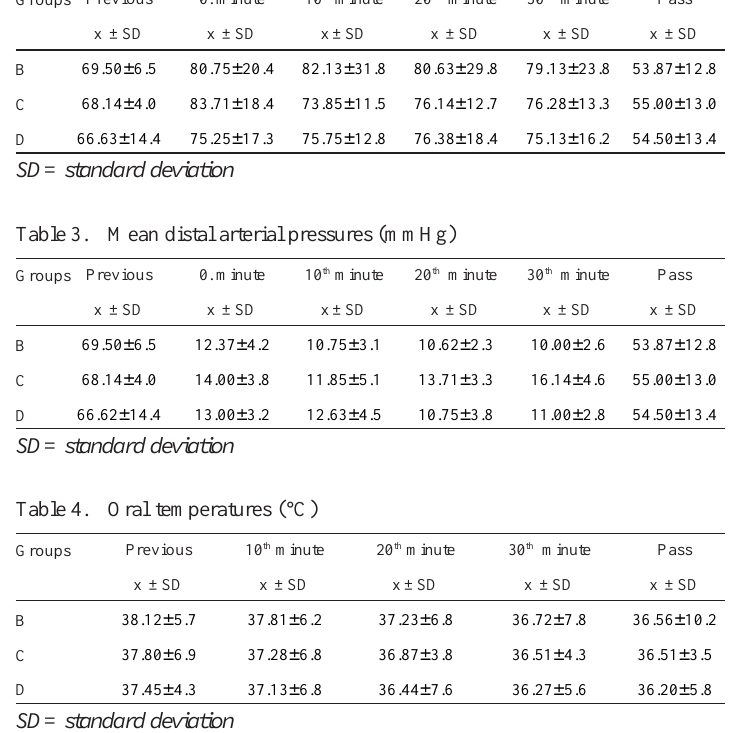
Table 2. Mean proximal arterial pressures mPAP (mmHg) Groups